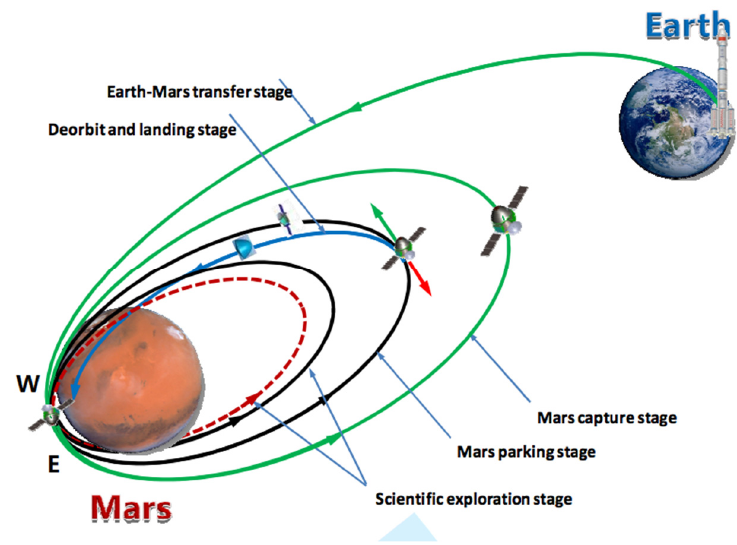
Figure 1. China Mars Mission Tianwen ‐ 1 orbit.